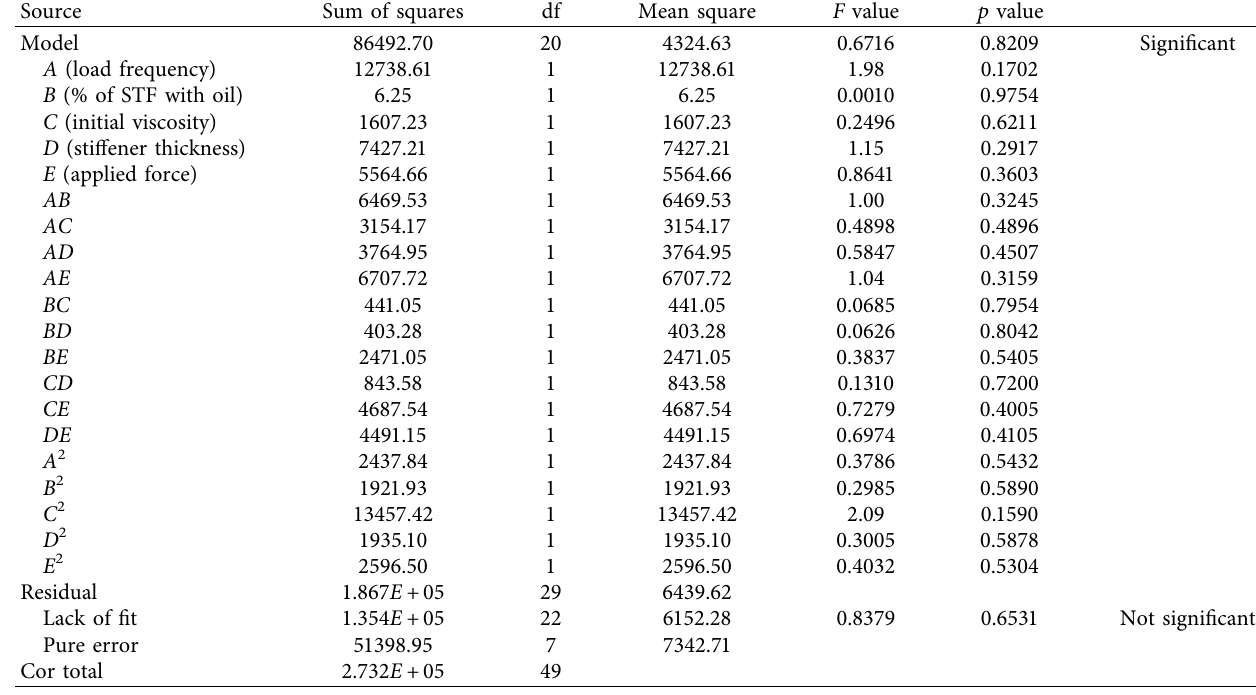
Table 5: ANOVA for efective